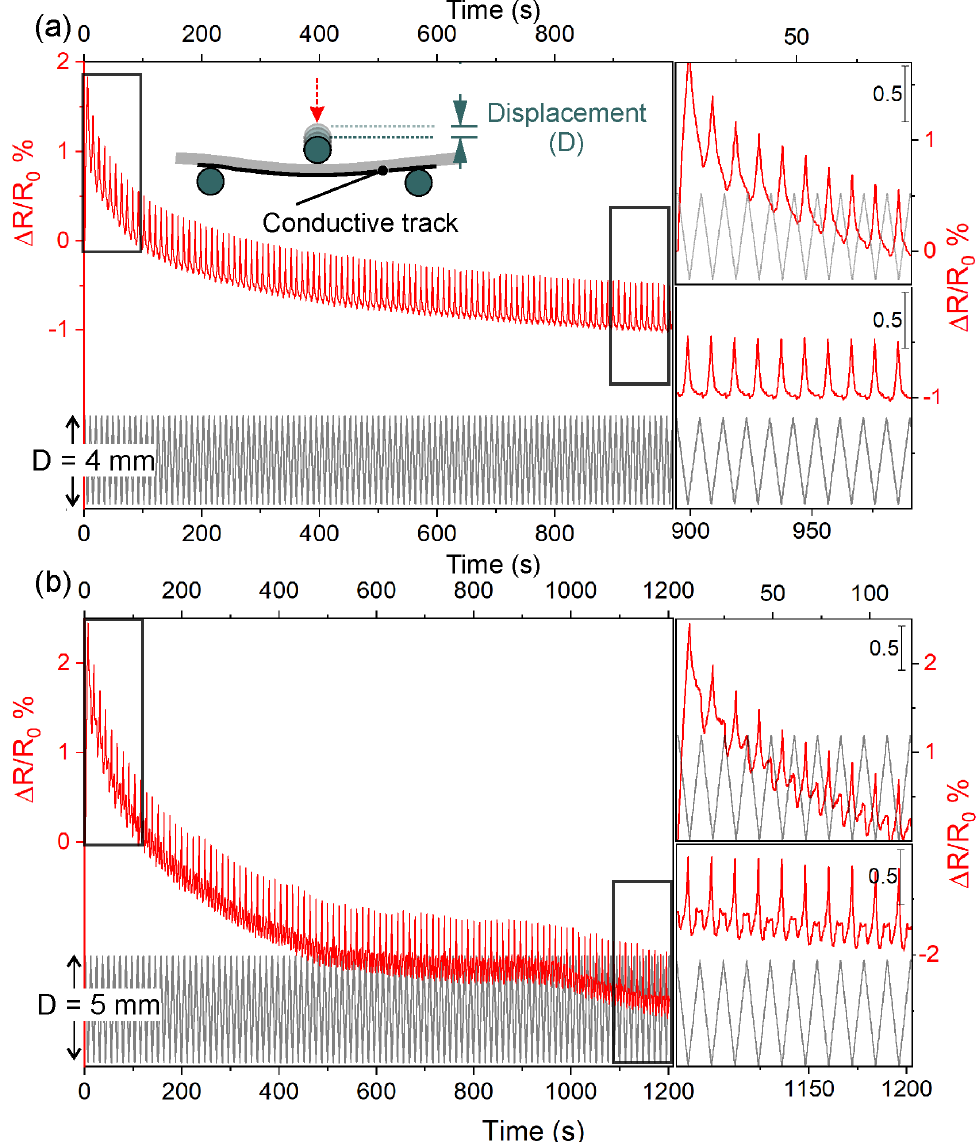
Figure 9. Variation of ∆ R/R 0 (red line) for 100 loading/unloading cycles (black line) using a cycling speed of 50 mm/s under different displacements: ( a ) 4 mm and ( b ) 5 mm. ∆ R/R 0 variation in the first and last 10 loading/unloading cycles of ( a , b ) is shown in the top and bottom insets of each plot, respectively.